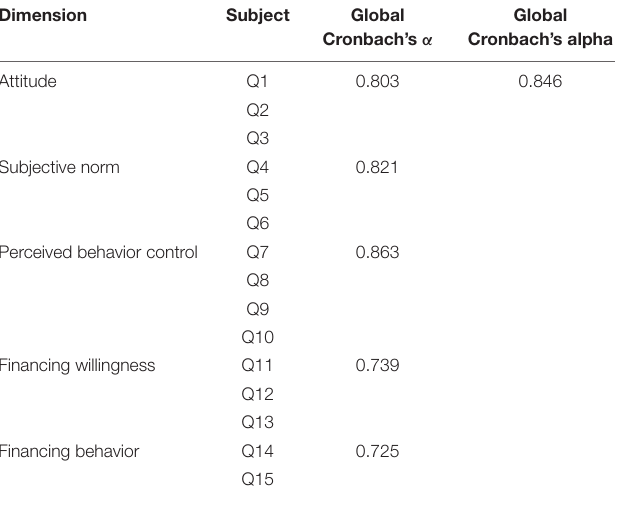
TABLE 2 | Reliability test